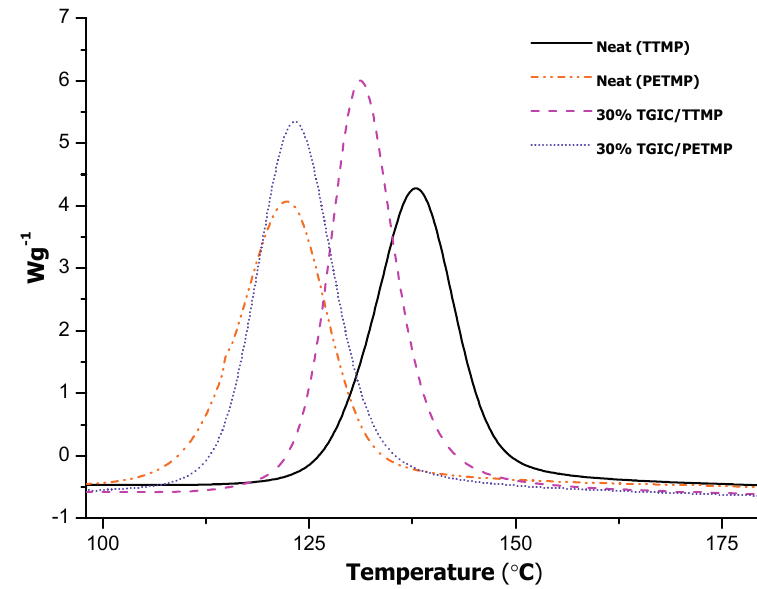
Figure 3. DSC thermograms corresponding to the dynamic curing at 10 °C/min of the mixtures epoxy resin-thiol tri- and tetrafunctional thiol catalyzed for 0.5 phr of